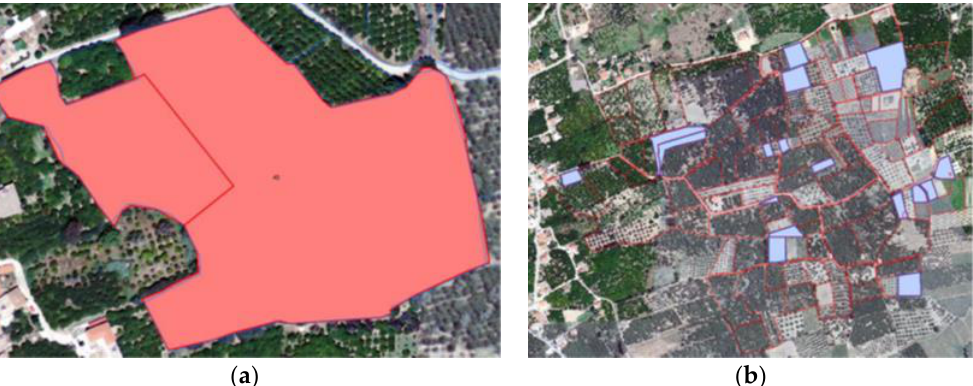
Figure 8. ( a ) Comparison of the recorded boundaries using the proposed procedure (in blue) with those obtained from the official Cadastral Maps (in red). ( b ) Obvious errors in parcel boundaries - Different recorded property boundaries.